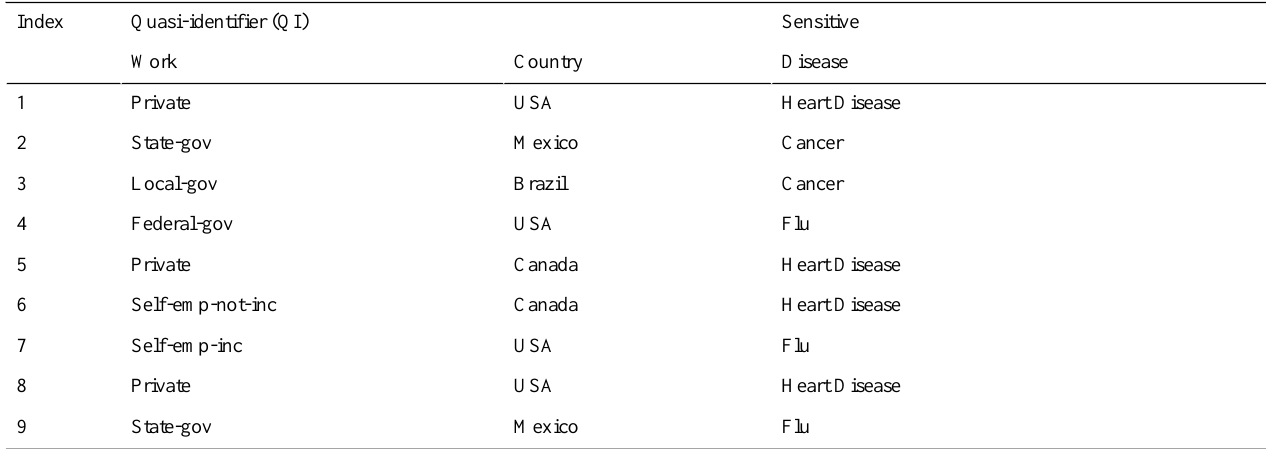
Table 1. An example of an original data